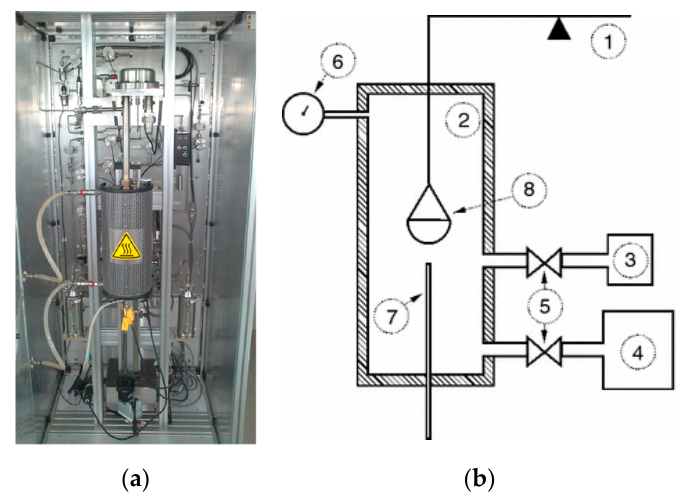
Figure 8. Photo ( a ) and scheme ( b ) of essential parts of operating unit of the thermogravimeter TGA-HP50 for sorption experiments: 1: High-sensitivity balance, 2: Tempered measuring cell, 3: VOC container, 4: Vacuum accessories, 5: Automatic valves, 6: Pressure transducer, 7: Thermocouple, 8: Measuring can with the tested sorbent.